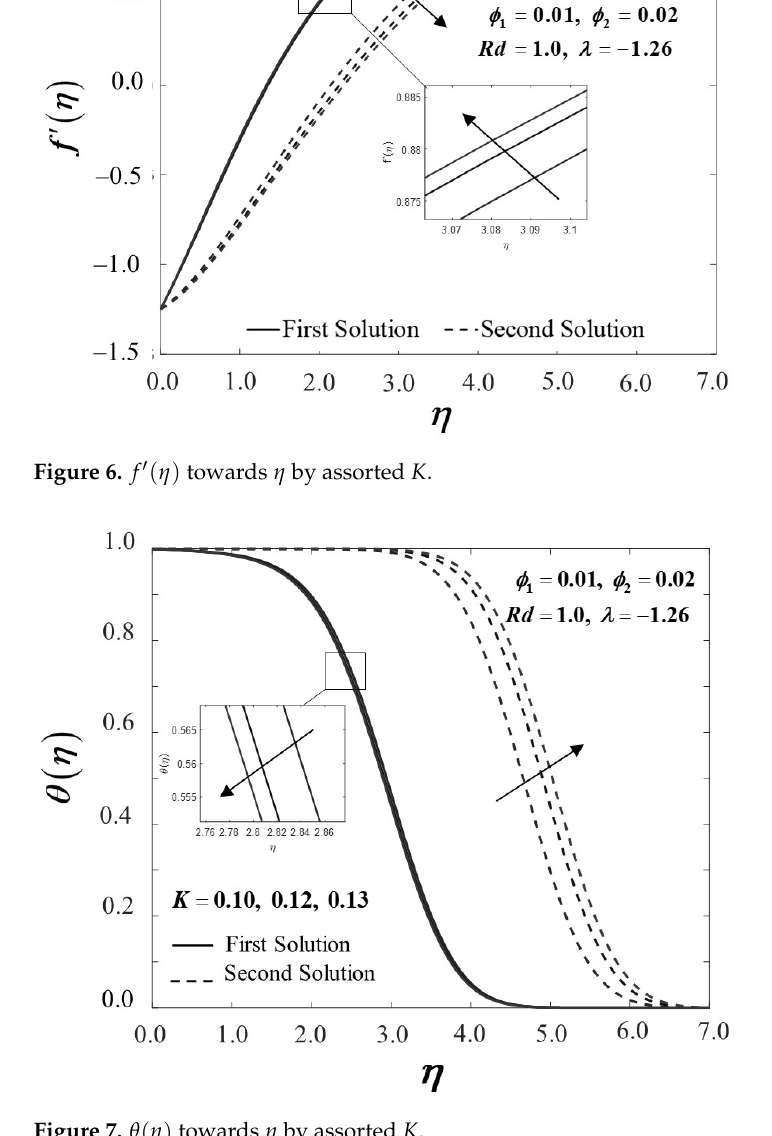
Figure 7. Figure 7.